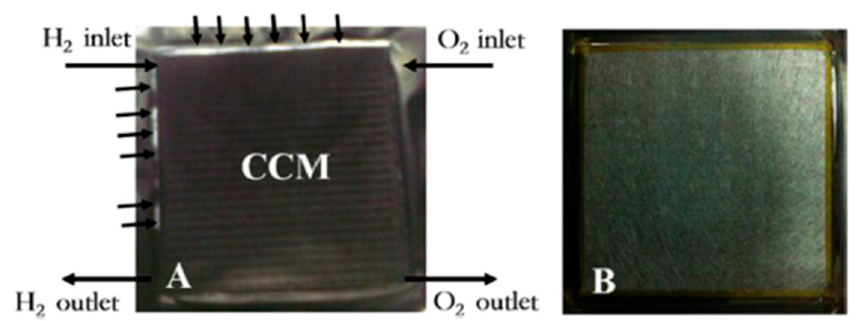
Figure 5. ( a ) The picture of MEA edge damage image; ( b ) The picture of MEA with edge protec- tion